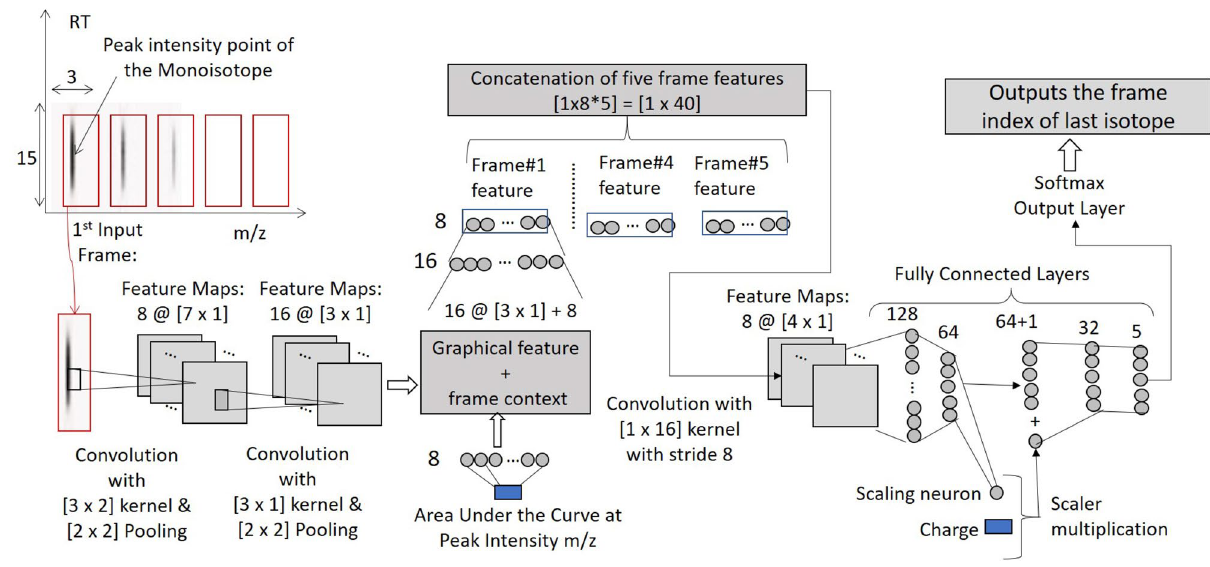
Figure 10. The network of IsoGrouping module. It starts with two convolution layers to fetch the graphical features from the input frame. Then we concatenate the intensity of the isotopic signal (area under the bell shaped isotopic signal) with it through an embedding layer of neurons (frame context). Then this is passed through two fully connected layers having sizes 16 and 8. This gives us the ‘frame feature’ of the input frame. We perform the same for five consecutive frames and then concatenate the ‘frame feature’ of those altogether. Then one layer of convolution is applied to detect the combined feature from all the frames. The resultant features are passed through two fully connected layers (size 128 and 64) to decide whether this is a noise or potential feature. This probability is also used to activate a scaling neuron, that feeds the charge into the network through proper scaling. The scaled charge is concatenated with the latest layer output (size 64) and passed through two fully connected layers. Finally, the Softmax output layer at the end classifies the sequence. We include pooling layers after the first and second convolution layers. We apply the ReLu activation function for the neurons. The dropout layers are included after each fully connected layer with a dropout probability of 0.5. The other network parameters are mentioned in the